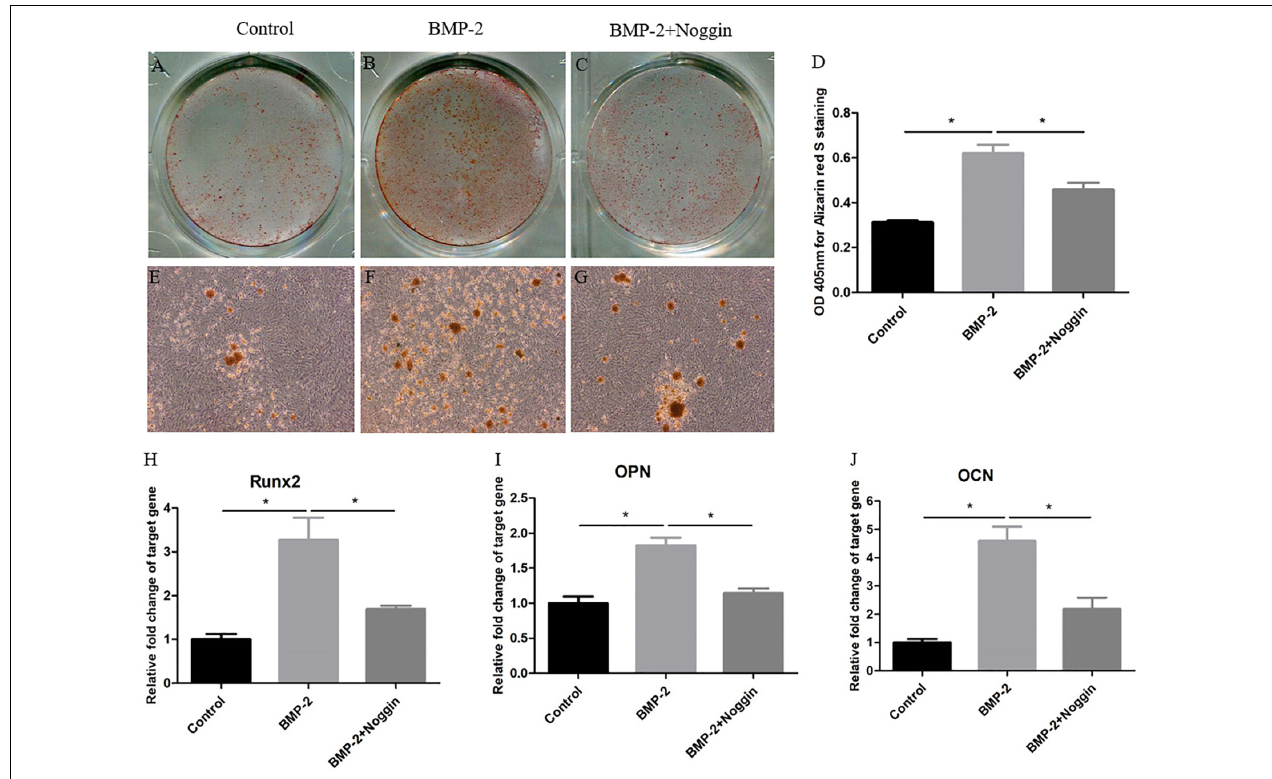
FIGURE 7 | BMP-2 stimulates the osteogenic differentiation of Y-TSPCs. Effect of BMP-2 on the osteogenic differentiation of Y-TSPCs isolated from ossified tendon aged 4M. Graphs show that BMP-2 stimulates osteogenic differentiation tendency of TSPCs (A,B,E,F) and noggin inhibited BMP-2-induced potentiation of osteogenic differentiation (B,C,F,G) at day 7 as indicated by Alizarin red S staining. Statistical diagrams show the quantification of the amount of Alizarin red S bound to the calcified deposits in TSPCs with BMP-2 or noggin stimulation at day 7 (D) . Statistical diagrams show the mRNA expression of Runx2 (H) , OPN (I) , and OCN (J) in TSPCs upon treatment with BMP-2 or noggin in vitro. Magnification × 1 (A–C) and × 40 (E–G) . ∗ P <